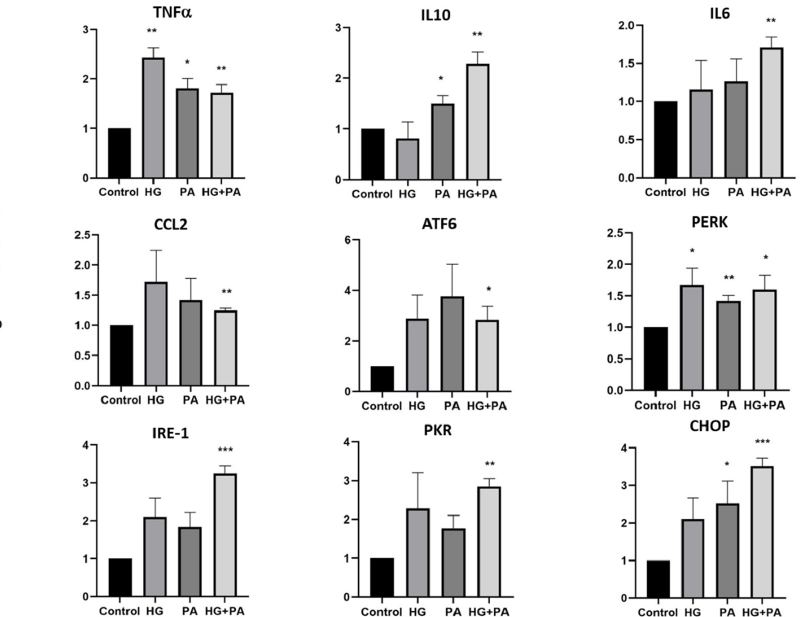
Figure 4. Gene expression levels of inflammatory and ER stress markers in THP1 cells treated for four hours. Gene expression levels of inflammatory markers (TNF α , IL10, IL6, CCL2) and ER stress markers (ATF6, PERK, IRE1, PKR and CHOP) were measured by quantitative real-time PCR in THP1 cells treated with high glucose (25 mM), palmitate (200 µM) and the combination for 4 h ( n = 3 for each condition). Data are normalized to internal GAPDH and presented as fold-change com- pared with Control data. One-way ANOVA with repeated measurements followed by Sidak´s post hoc test were used to determine the significance of differences in means between the groups (* p < 0.05, ** p < 0.01, *** p < 0.001).